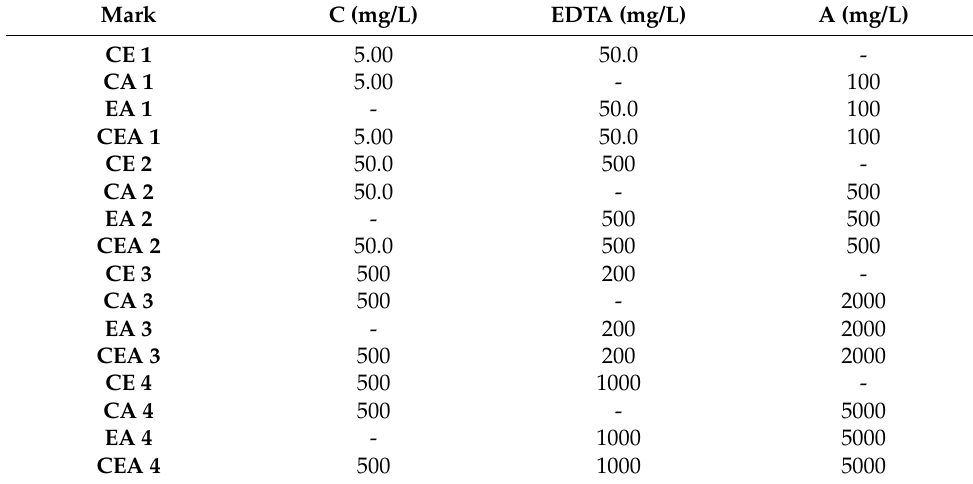
Table A1. Information on the tested antioxidant combinations for vitamin D3 stabilization (vitamin D3 concentration was 20 mg/L in all